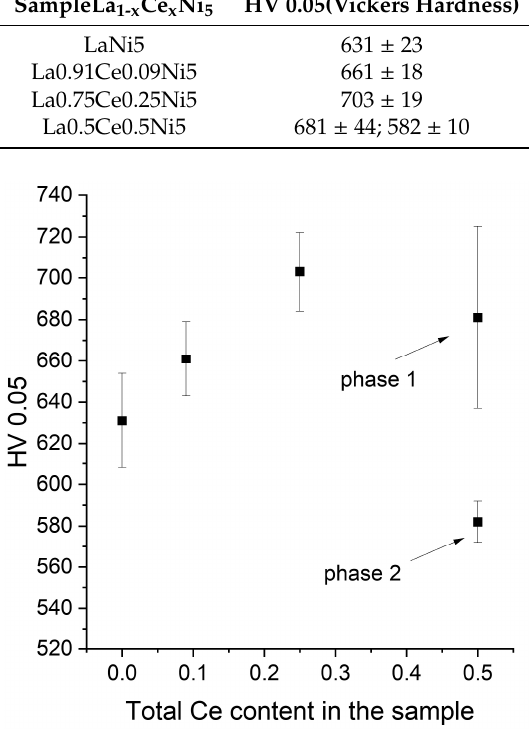
Figure 7. Microhardness values of the investigated samples.